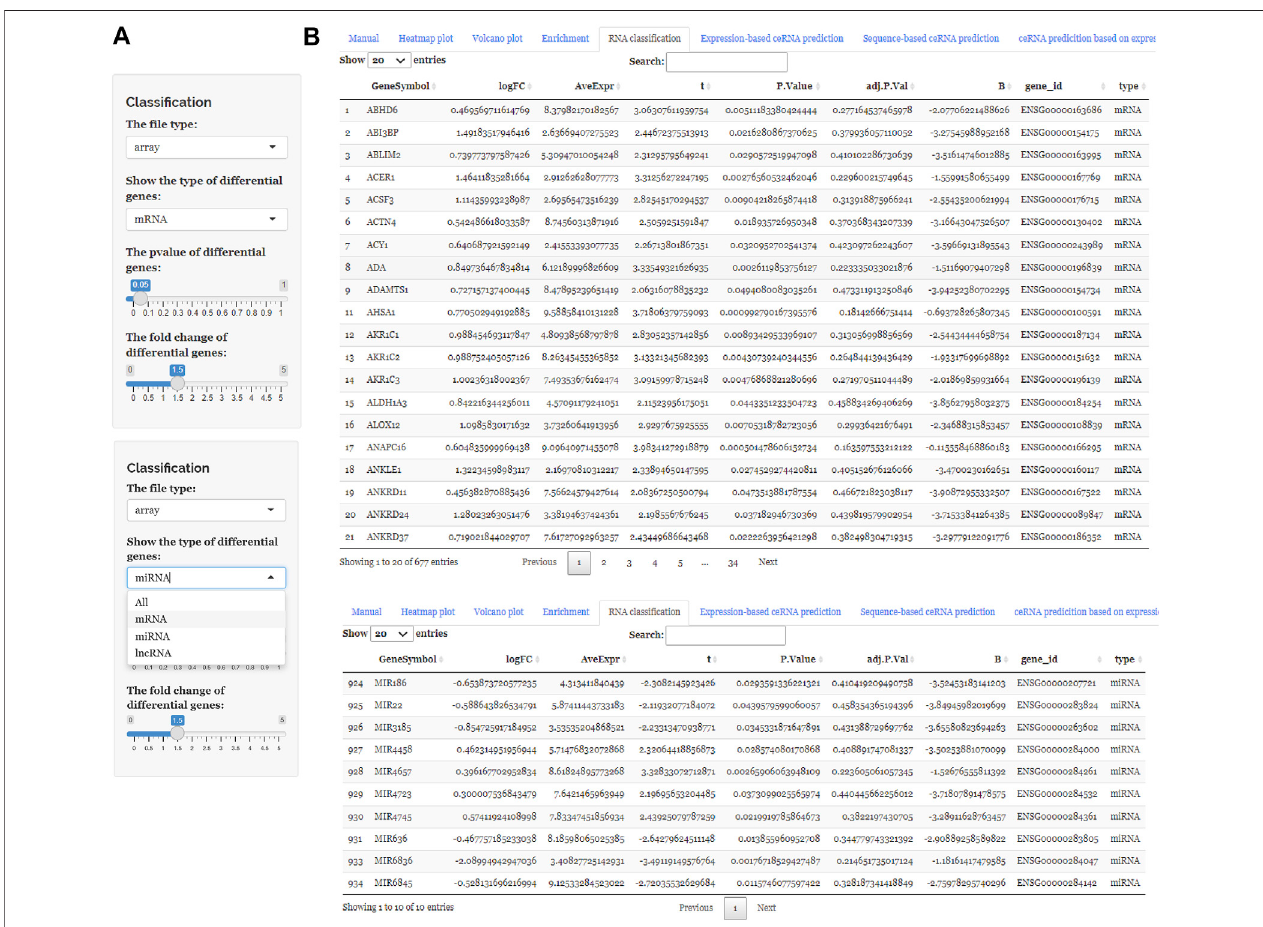
FIGURE 3 | Using ceRNAshiny to classify RNAs. (A) Panels to show the type of differential genes and to adjust parameters. (B) The generated results of RNA classi fi cation using the template dataset.